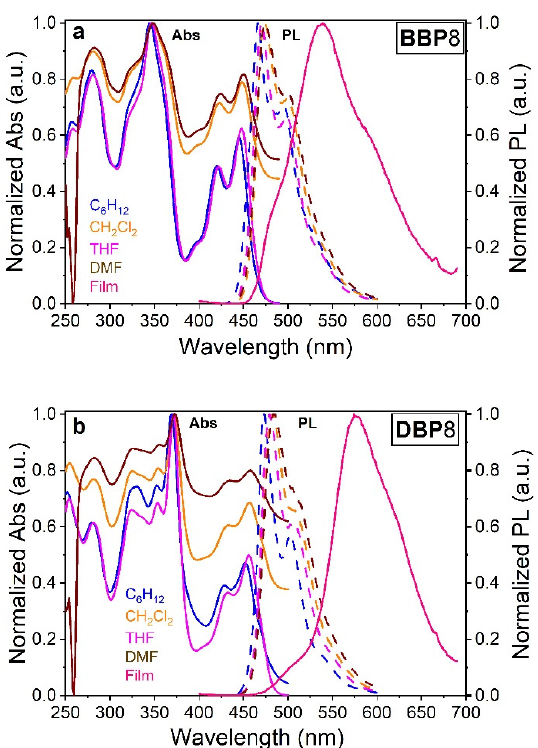
Figure 6. Photophysical properties of BBP 8 and DBP 8: UV–Vis absorption, fluorescence emission in solution (c = 1 × 10 − 5 mol/L) in various solvents (cyclohexane, CH 2 Cl 2 , THF = tetrahydrofuran, and DMF = N,N ‐ dimethylformamide) and fluorescence emission in film of ( a ) BBP 8 and ( b ) DBP 8. Table 2. Spectroscopic parameters of BBP 8 and DBP 8 in various solvents and thin films a . Solution Film Compounds Solvent 𝛌 abs